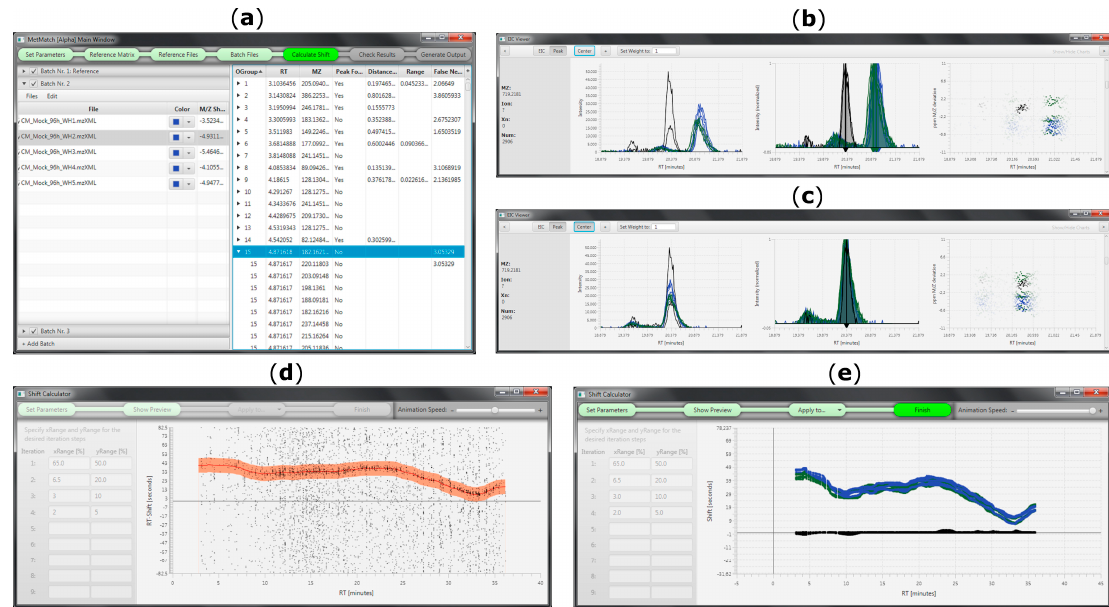
Figure 6. MetMatch’s user interface during various processing steps. ( a ) Main window showing the reference feature list and all loaded datafiles. The step indication bar on top helps the user to keep track of the data processing and also serves as a menu bar; ( b ) EICs of reference (black) and target datafiles (blue, green) before Rt alignment; ( c ) Overlay of EICs after Rt alignment; ( d ) Animated Rt shift detection algorithm (animated version available at [26]; ( e ) Overlay of Rt shift functions calculated for multiple target datafiles.